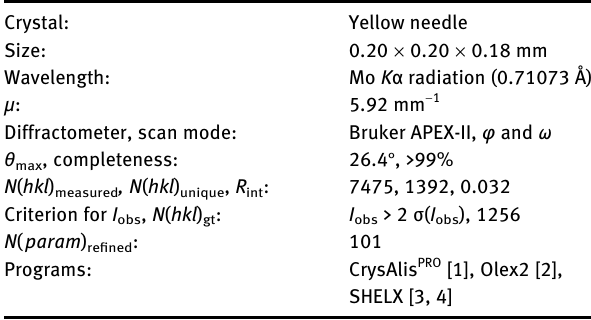
Table  : Data collection and handling.